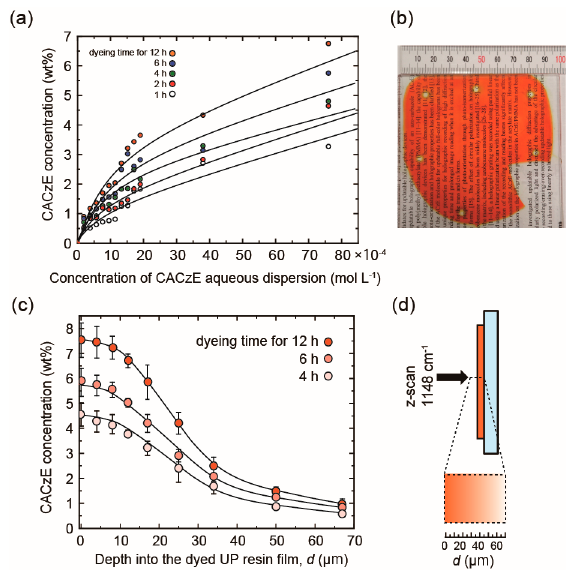
Figure 5. ( a ) Dye uptake isotherms of the CACzE dye on the UP resin film (dyebath temp. 120 °C); ( b ) a photograph of an UP resin film with 100 mm square after dyeing; ( c ) CACzE concentration vs. depth profiles for the dye-doped UP resin films (Entry 10); and ( d ) a schematic illustration of dye-doped UP resin film.